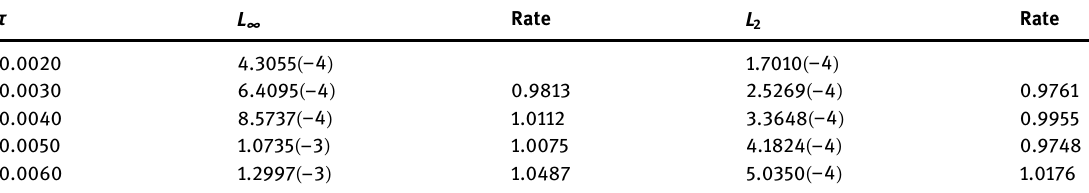
Table 11: L 2 , L ∞ errors and rate at = T 0.1 and = h 0.008 by the HOC - LOD scheme for variable τ for Example 5